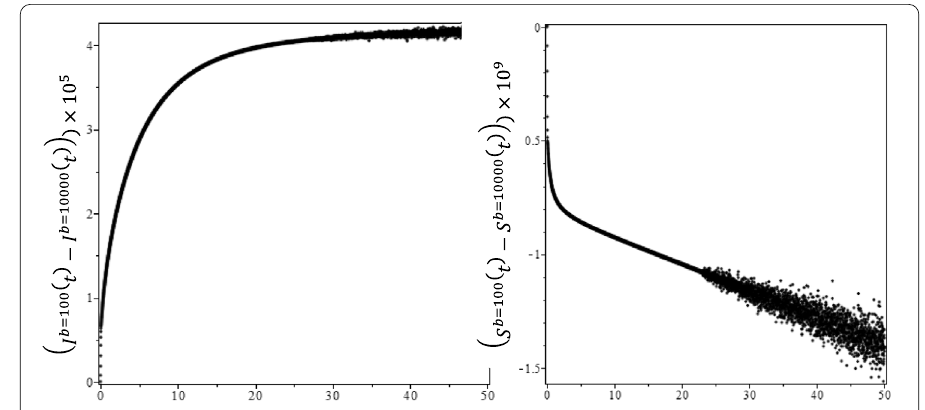
Figure 3 The differences of active infected cases and suspected individuals for b = 100 and b = 10,000